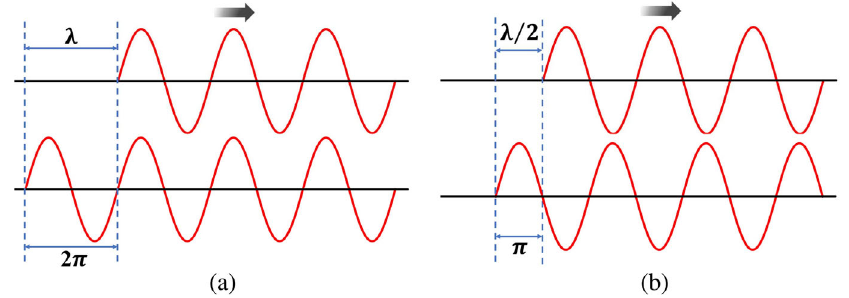
FIG. 5. (a) Constructive interference. (b) Destructive